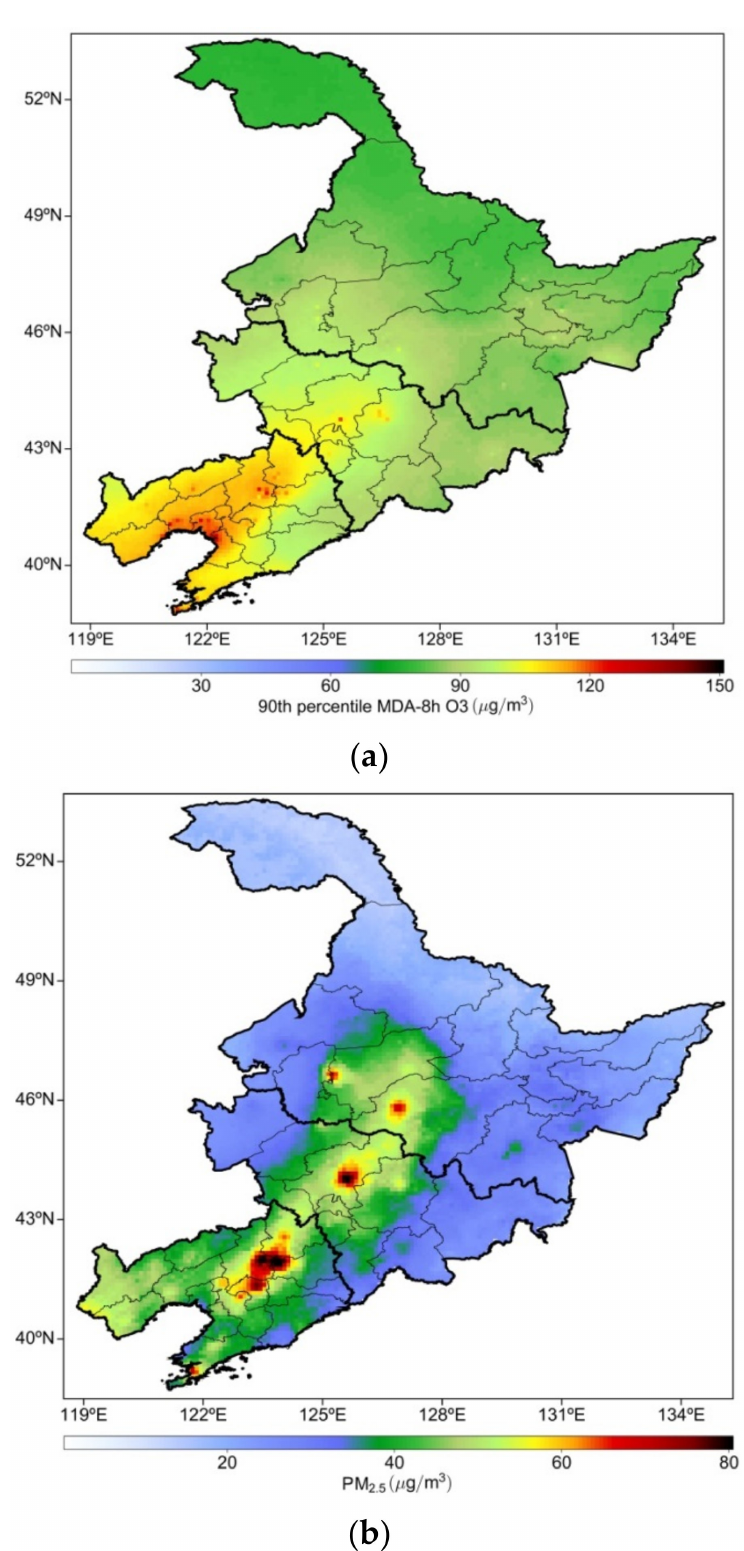
Figure 2. Spatial distribution of mean annual concentrations of ( a ) O 3 -8h-90per averaged from 2013–2020 and ( b ) PM 2.5 averaged from 2001–2020 in